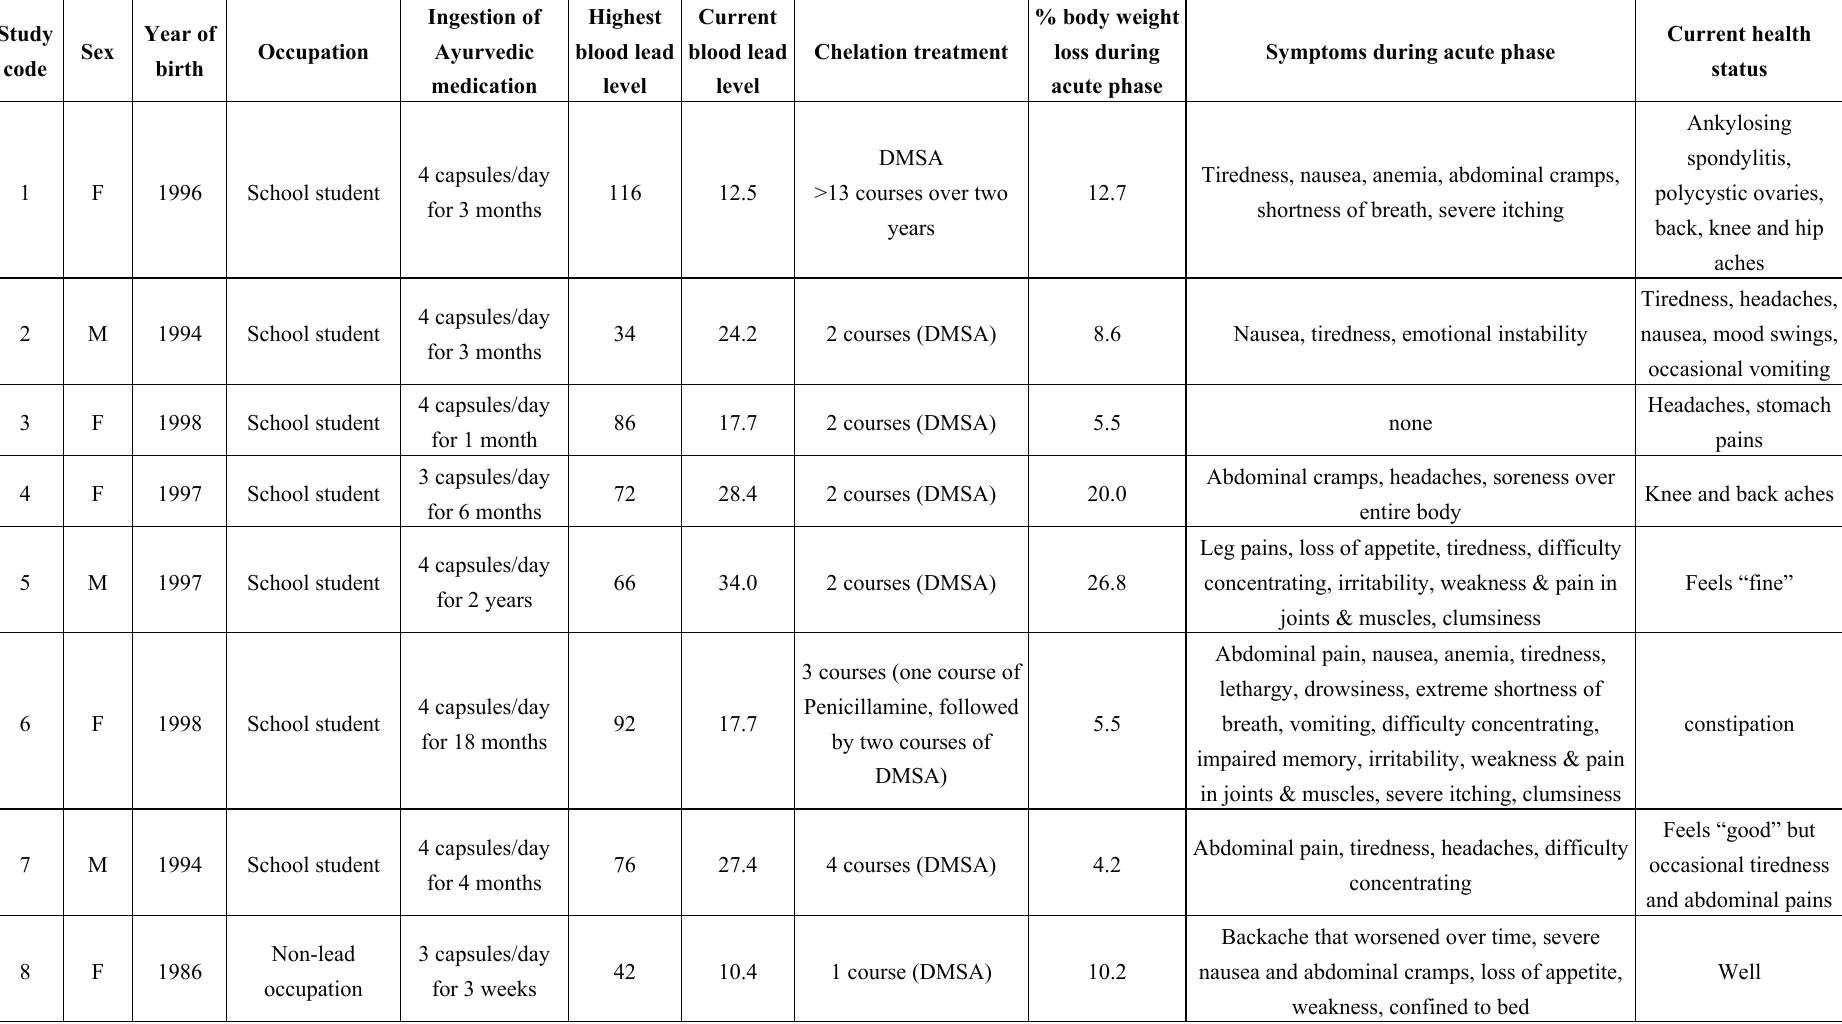
Table 1. Profile and outbreak summary by